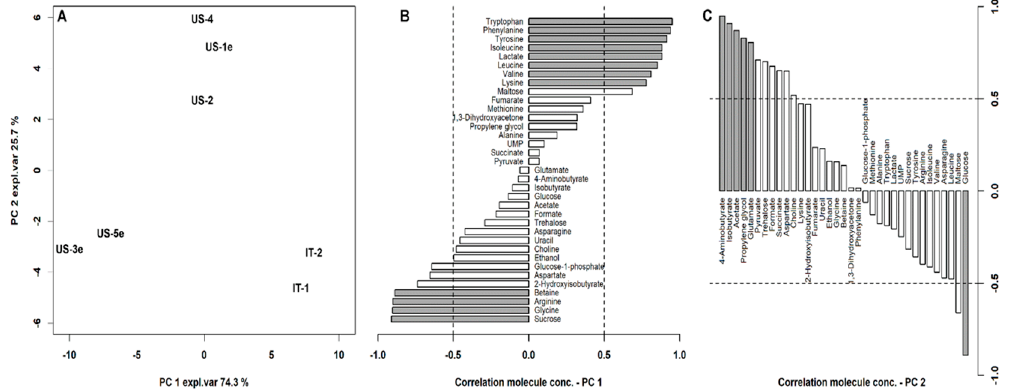
Figure 5. ( A ) Score plot of an rPCA model on the molecules quantified by proton nuclear magnetic spectroscopy ( 1 H-NMR) on VSL#3 products. ( B , C ) Correlation between molecules concentration and their importance over PC1 and 2, respectively. Gray bars highlight statistically significant correlations ( p < 0.05).